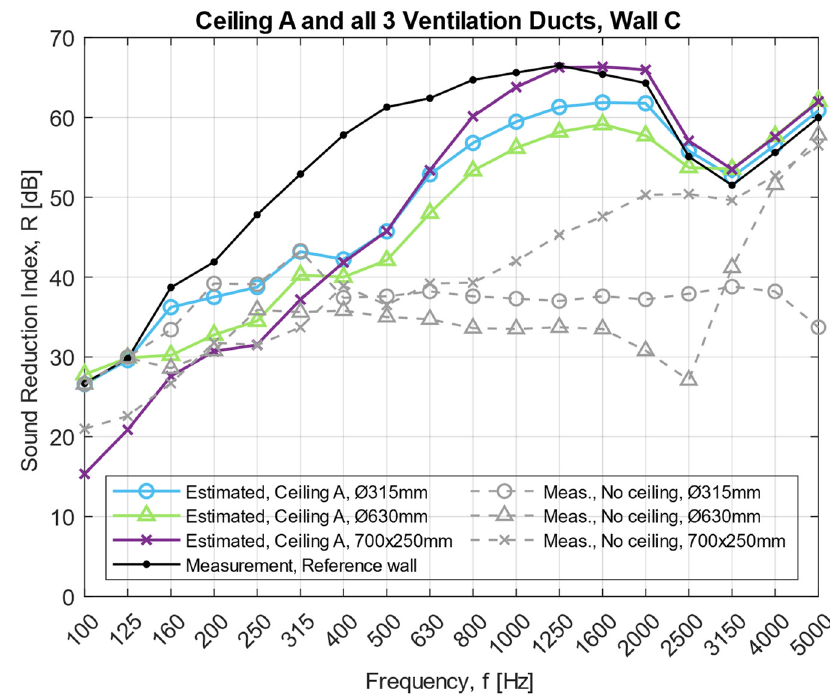
Figure 9. Estimated theory with a suspended absorbent ceiling, Ceiling A, as acoustical treatment. Ventilation duct with dimensions of Ø315, Ø630 and 700 × 250 mm through wall C with a sound reduction index of R w = 54 dB.